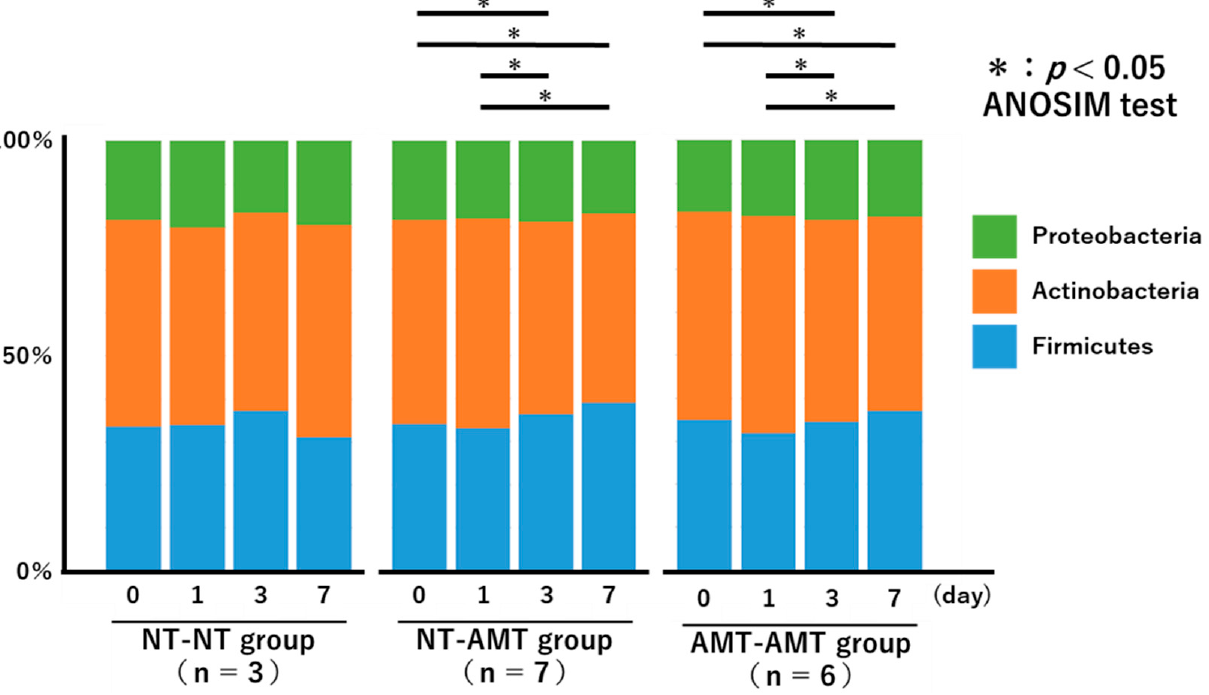
Figure 2. A 100% stacked bar chart showing the relative proportions of the phyla of the identified bacteria over time (day 0, 1, 3, 7) in each treatment group (NT-NT, NT-AMT, AMT-AMT) for mastitis with Gram-positive bacteria. Asterisks represent significant differences from the results of the ANOSIM test among the days within the same group. The three most abundant phyla are Actinobacteria, Proteobacteria and Firmicutes. According to the results of the ANOSIM test, there was no significant change in the NT-NT group, but significant changes were seen between days 0 and 3, days 0 and 7, days 1 and 3 and days 1 and 7 in the NT-AMT group, and between days 0 and 3, days 0 and 7, days 1 and 3 and days 1 and 7 in the AMT-AMT group.